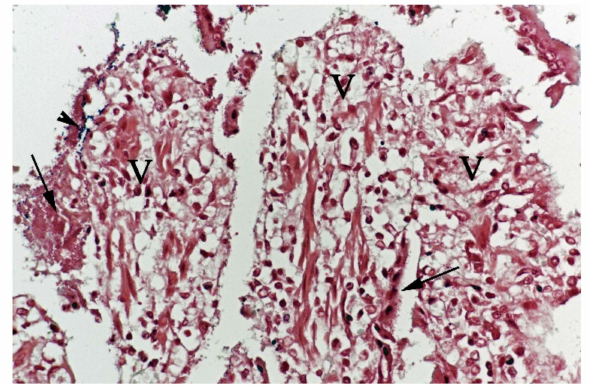
Figure 5. Histological section from small intestine dog with acute haemorrhagic diarrhoea, Gram- stain. Large amounts of small Gram-negative rods (arrows) were located as single bacteria or thick layers close to the surface of the villi (V). Small amounts of large Gram-positive rods (arrowhead) were present in the clusters of Gram-negative bacteria.